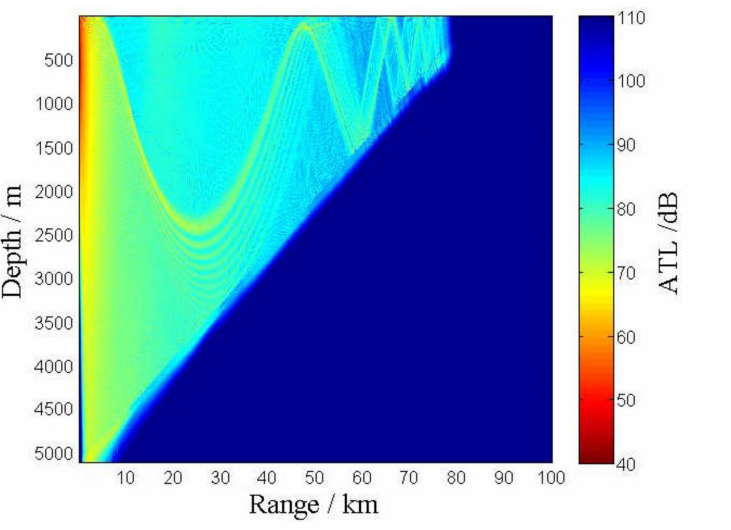
Figure 7. Average transmission loss in the upslope waveguide when the source depth is 550 m. The HLA is suspended at a depth of 120 m, 48 km away from the source (at the direction of end-fire). The ATL s at distance 48 km are calculated as the function of element number which are displayed in Figure 8a. As can be seen from the Figure 8a, ATL s have rapid fluctuation compared to simulations B (Figure 3a for shallow water) and C (Figure 5a for deep sea). The variance of ATL s’ fluctuation is 30.55 dB, which is larger than those in simulations B and